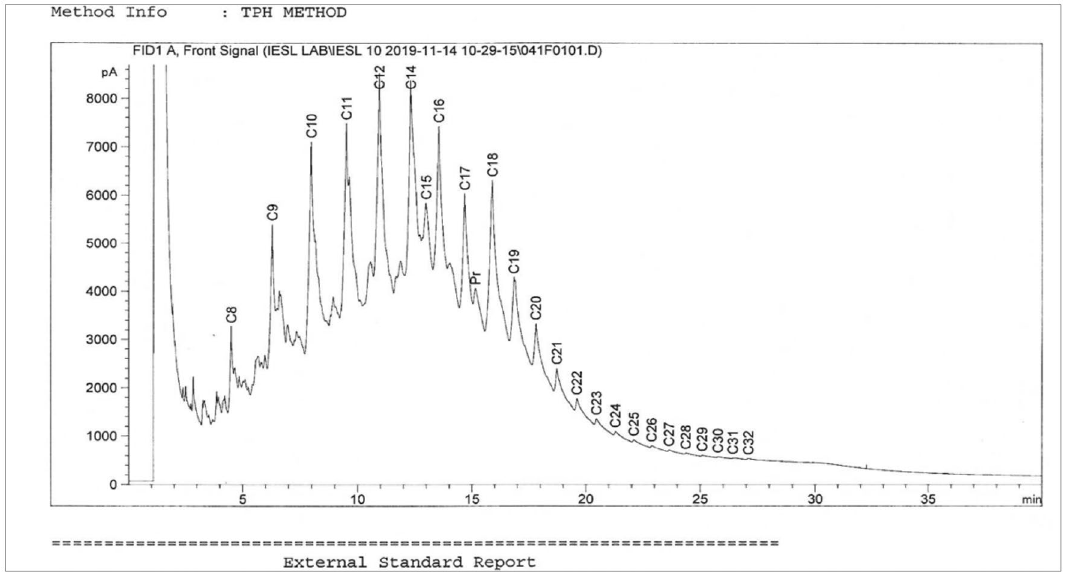
Fig. 1 Chromatogram of the Niger Delta crude oil sample